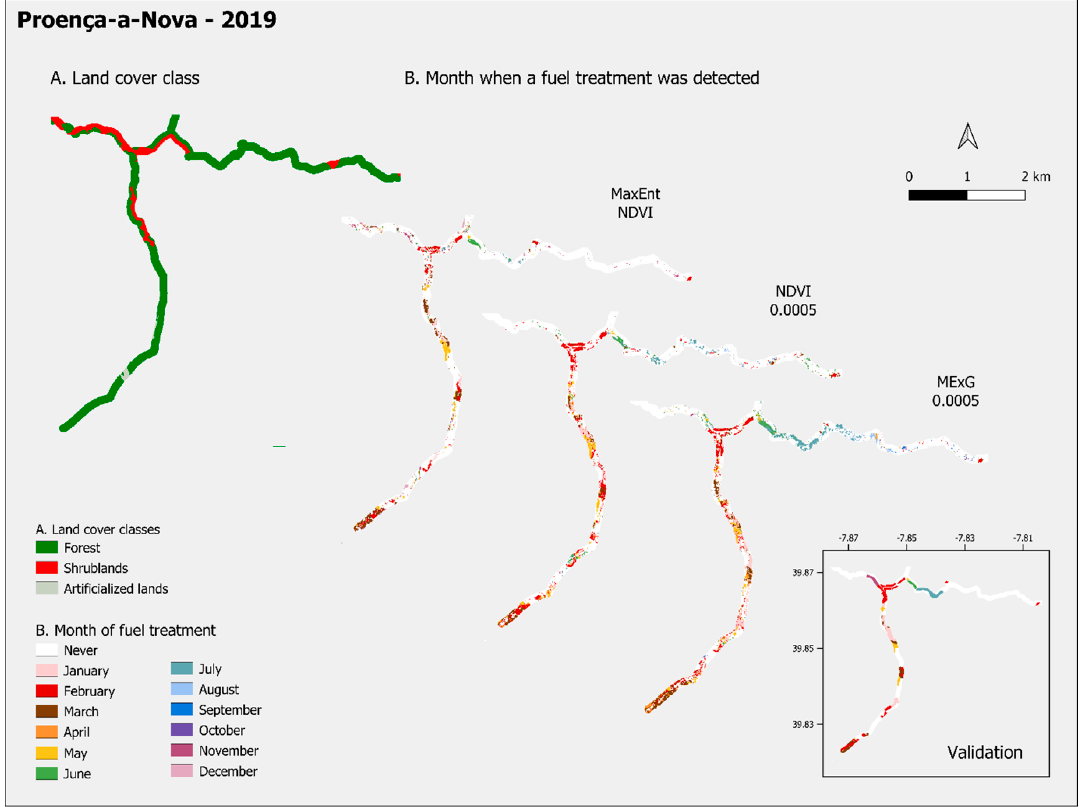
Figure 9. Results in a pine forest area of Proença-a-Nova for the year 2019: A. land cover; B. results of Method 1, MaxEnt NDVI classification, and Method 2, NDVI and MExG statistical detection with α = 0.0005. In the part of the fuel break oriented N-S, the vegetation was first slashed and removed three months later; validation gives the month of the